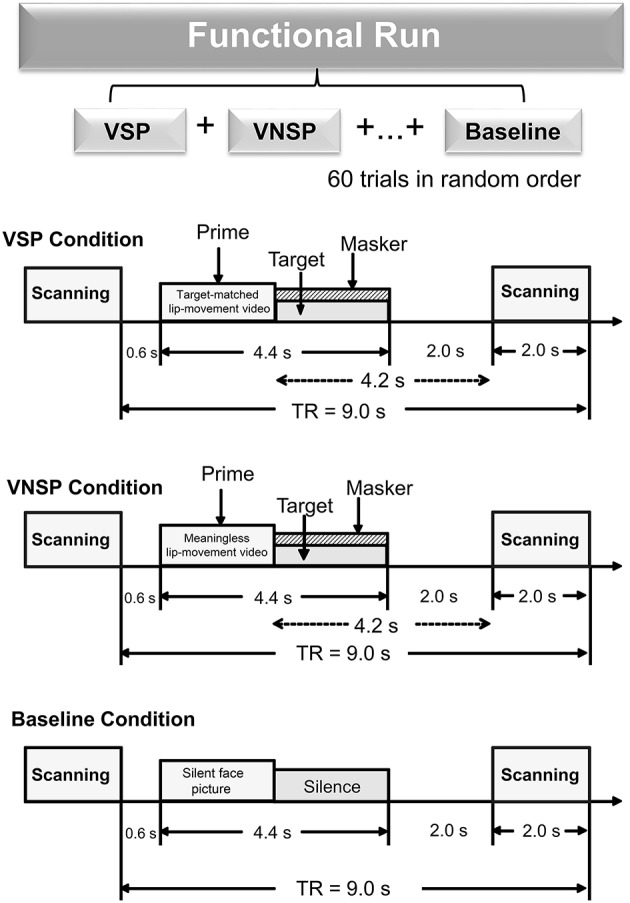
A functional run comprised 60 trials (20 trials for each of the three conditions: VSP, VNSP and baseline simulation) presented in random order. Sparse temporal sampling was used to acquire images. Trial structures of each of the three conditions were illustrated respectively. Under the visual priming condition, a priming stimulus was presented 600 ms after the scanning, then the target and masker sounds were co-presented, and terminated at the same time. The midpoint of the stimulus was presented 4.2 s prior to the next scanning. VSP, visual speech priming; VNSP, visual non-speech priming; TR, time to repeat.